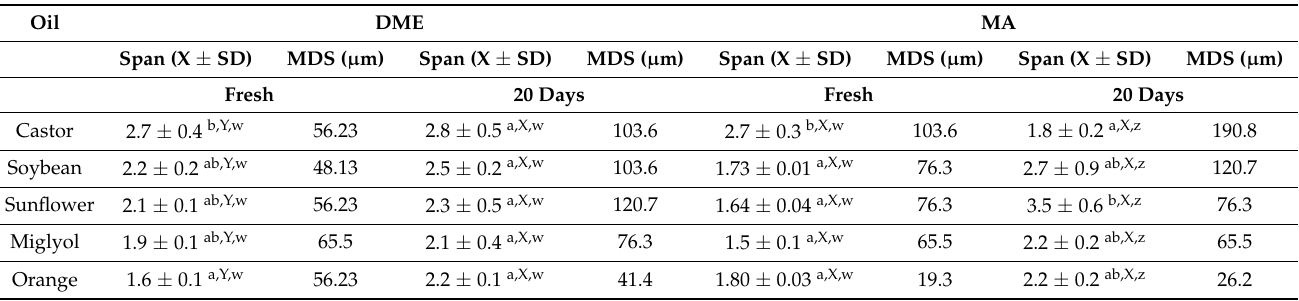
Table 2. Span value of DEs (W1/O/W2) with PPE encapsulated of one day and after storage (20 days) and main droplet size in DE fresh and after 20 days of